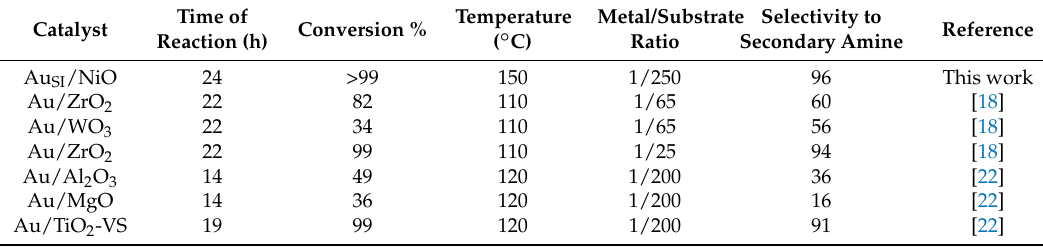
Table 4. Activity and selectivity of different Au systems for the reductive amination of benzyl alcohol with aniline. Catalyst